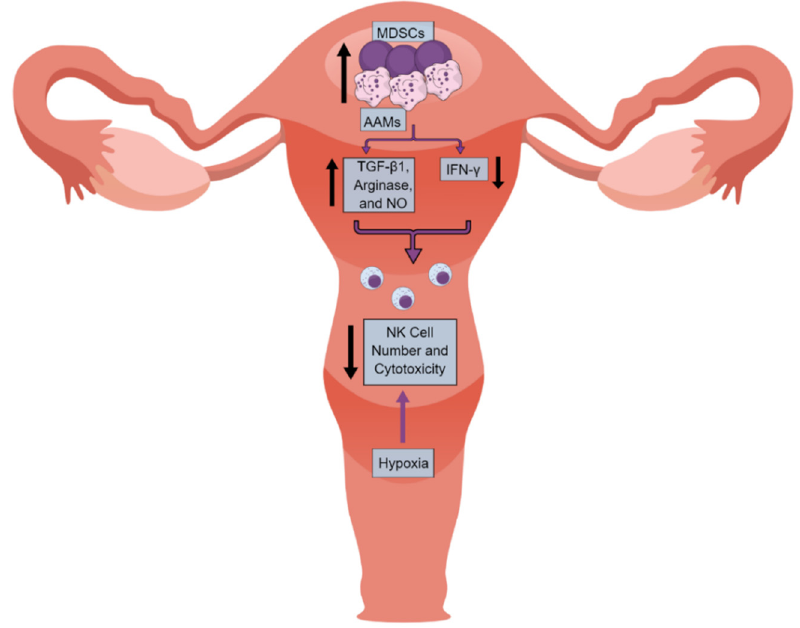
Figure 2. NK cell dysregulation in the immunosuppressive UCIM. Increased concentrations of MDSCs and AAMs in the tumor microenvironment (TME) increase TGF- β 1, NO., and arginase, as well as decrease IFN- γ levels, all of which contribute to NK cell dysregulation and depletion. The hypoxic environment characteristic of some uterine tumors can also contribute to NK cell dysregulation and depletion.